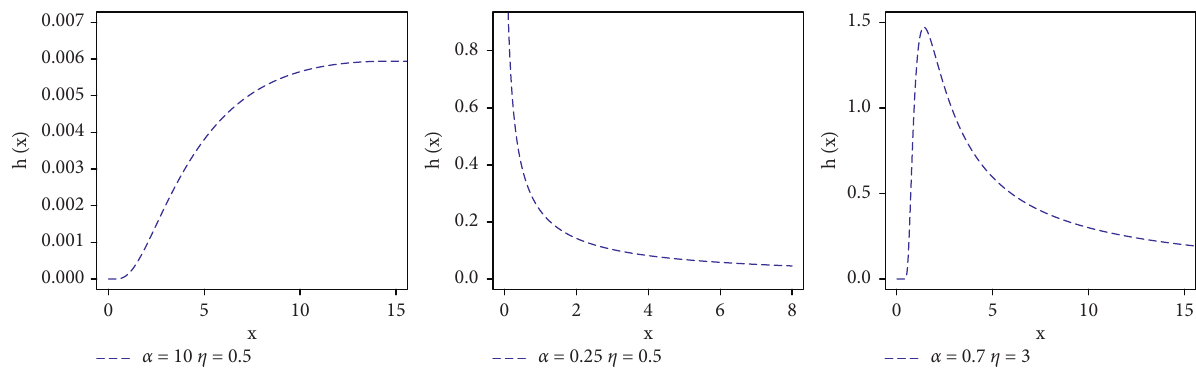
Figure 2: Possible failure rate shapes of the IPBH distribution for several values of α and η